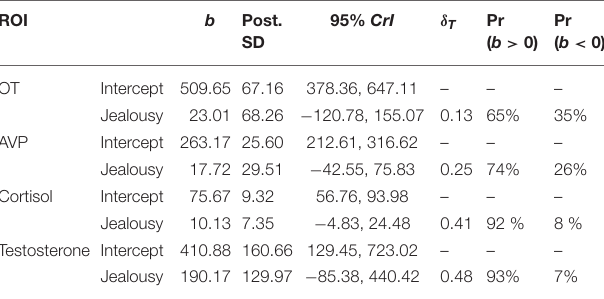
TABLE 5 | Multivariate multilevel model estimates for plasma hormone concentrations.